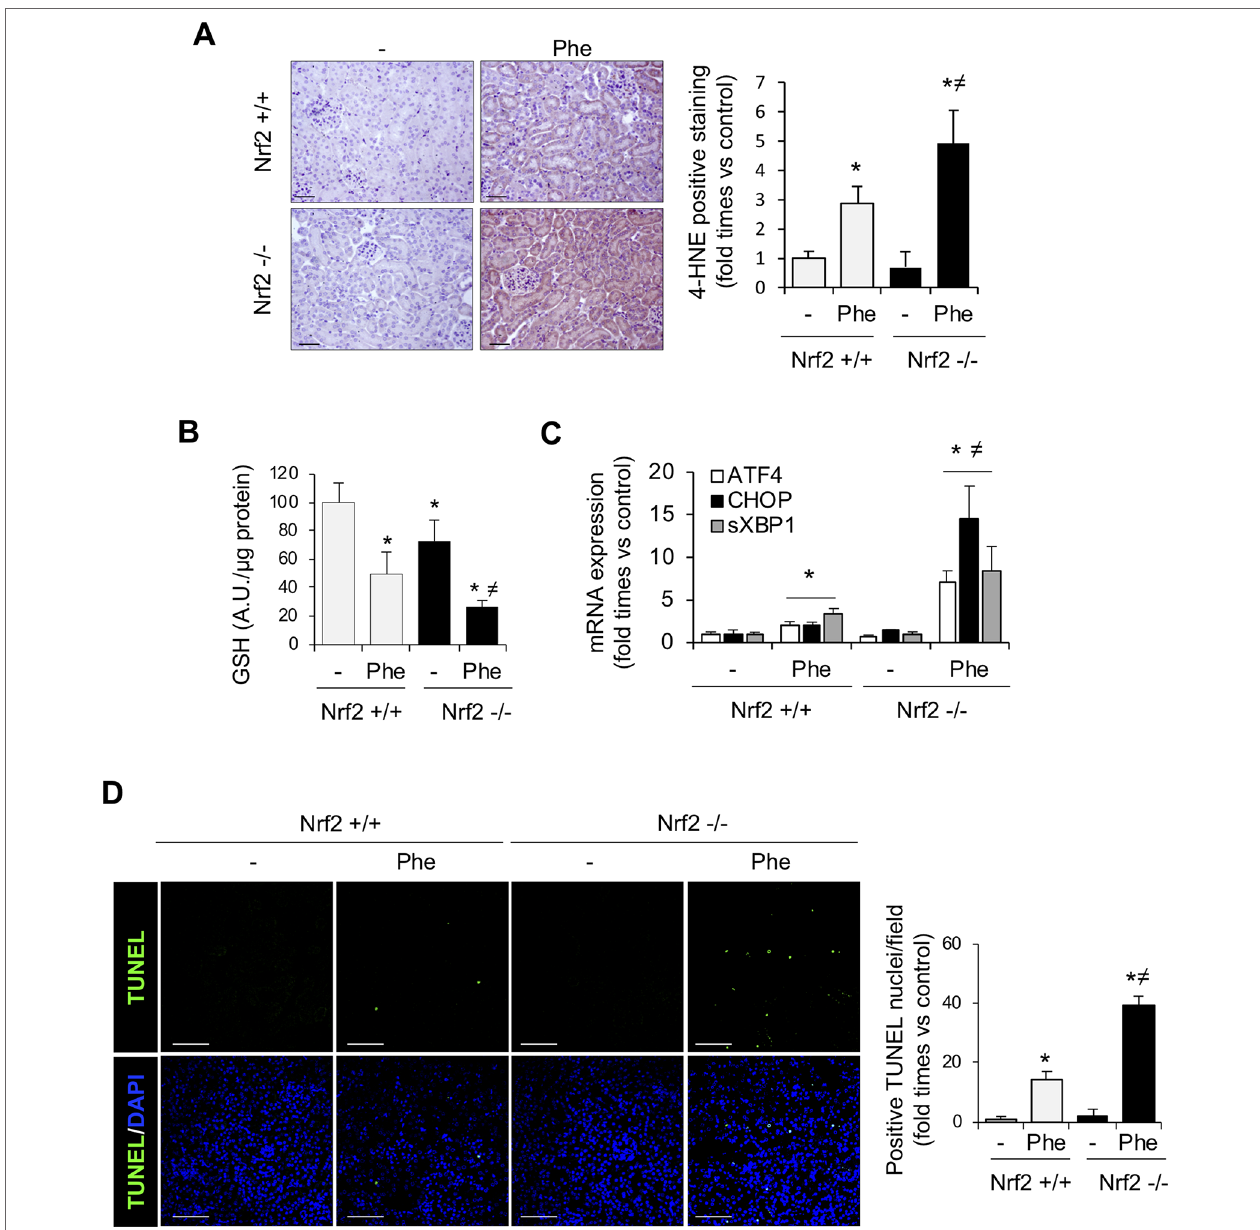
FIGURE 4 | Nrf2 protects against oxidative stress and cell death associated with intravascular hemolysis. C57BL/6 (Nrf2+/+) or Nrf2−/− mice (12 weeks old) were i.p. injected with saline (vehicle) or phenylhydrazine (Phe, 2 mg/10 g of body weight) to induce intravascular hemolysis ( n = 8/group). (A) Representative image of 4-hydroxynonenal (4-HNE) staining. Semi-quantification of 4-HNE-positive staining per renal cross section. (B) GSH content in renal tissue. (C) ATF4, CHOP, and sXBP1 mRNA levels determined in kidney by real-time RT-qPCR. (D) Representative confocal microscopy images showing nuclear staining of TUNEL (green) (left panel). Nuclei were stained with DAPI (blue); scale bar, 100 μm. Semi-quantitative analysis of TUNEL-positive cells (right panel). Results are expressed as mean ± SE. * p < 0.05 vs Nrf2+/+ control mice, ≠ p < 0.05 vs Nrf2+/+ Phe-injected